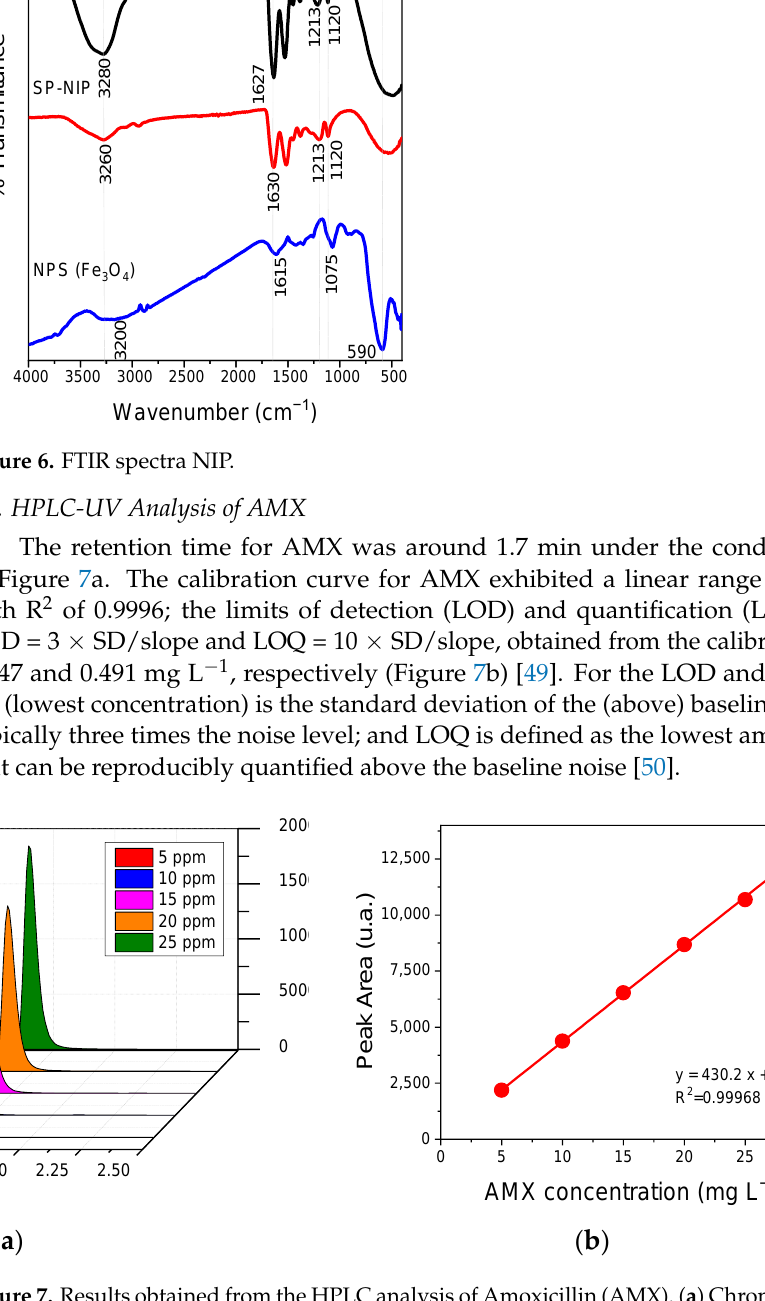
Figure 7. Results obtained from the HPLC analysis of Amoxicillin (AMX). ( a ) Chromatogram obtained for Amoxicillin (AMX) (5, 10, 15, 20, and 25 ppm); ( b ) Calibration curve of Amoxicillin (AMX).